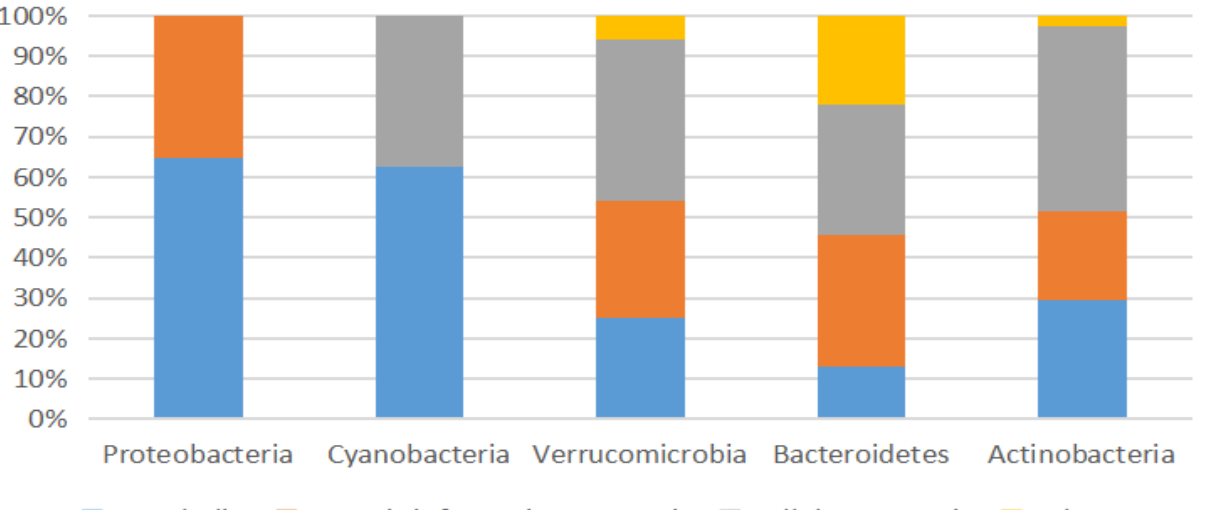
Figure 11. Top functional genes abundance in Oualidia using Prokka [24].